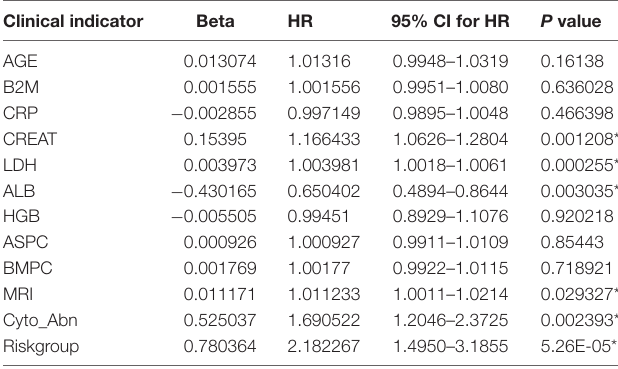
TABLE 2 | Multivariate Cox regression analysis of eleven clinical indicators and the five-gene risk